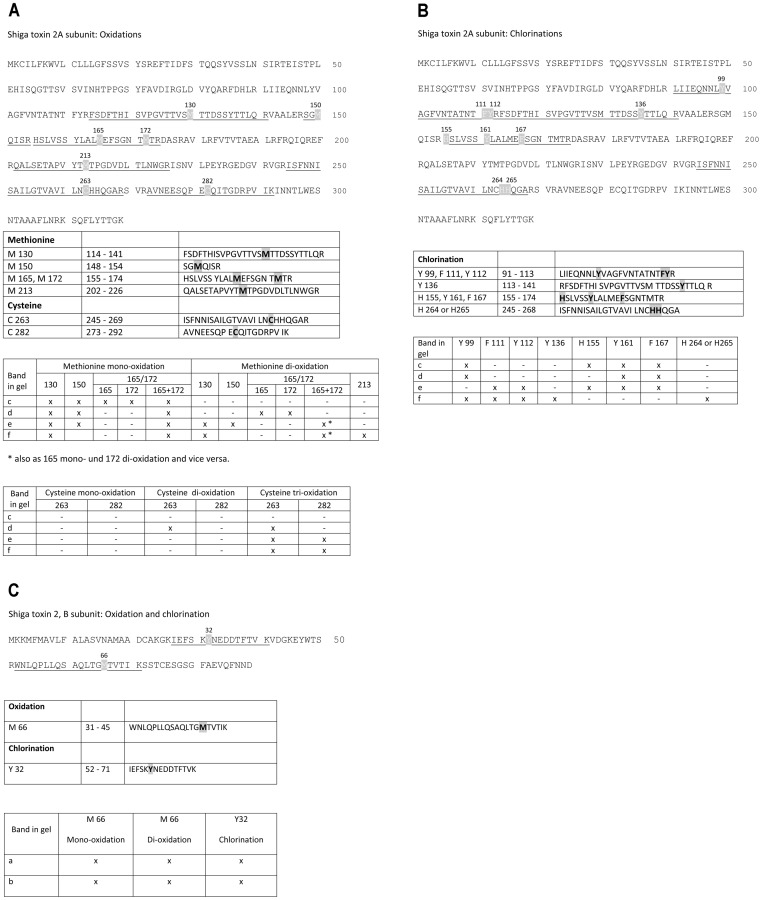
Oxidation of thio groups and aromatic groups of Stx2 detected with mass spectrometry.Bands a-f from the gels, as depicted for one representative in Figure 5, were analyzed with mass spectrometry after in-gel digestion. Similar results gained from three independent experiments are shown. Positions and occurrence in bands are demonstrated. Amino acids 1–22 (subunit A) and 1–19 (subunit B), respectively, comprise the signal peptides. (A) Oxidation of all methionines and cysteines of subunit A occurred. Positions of oxidized amino acids in the sequence are shown and their mono- to tri-oxidation in relation to the bands excised from the gels. (B) Chlorination of phenylalanine, tyrosine, and histidine of subunit A. (C) Oxidation of methionine and chlorination of tyrosine of subunit B.